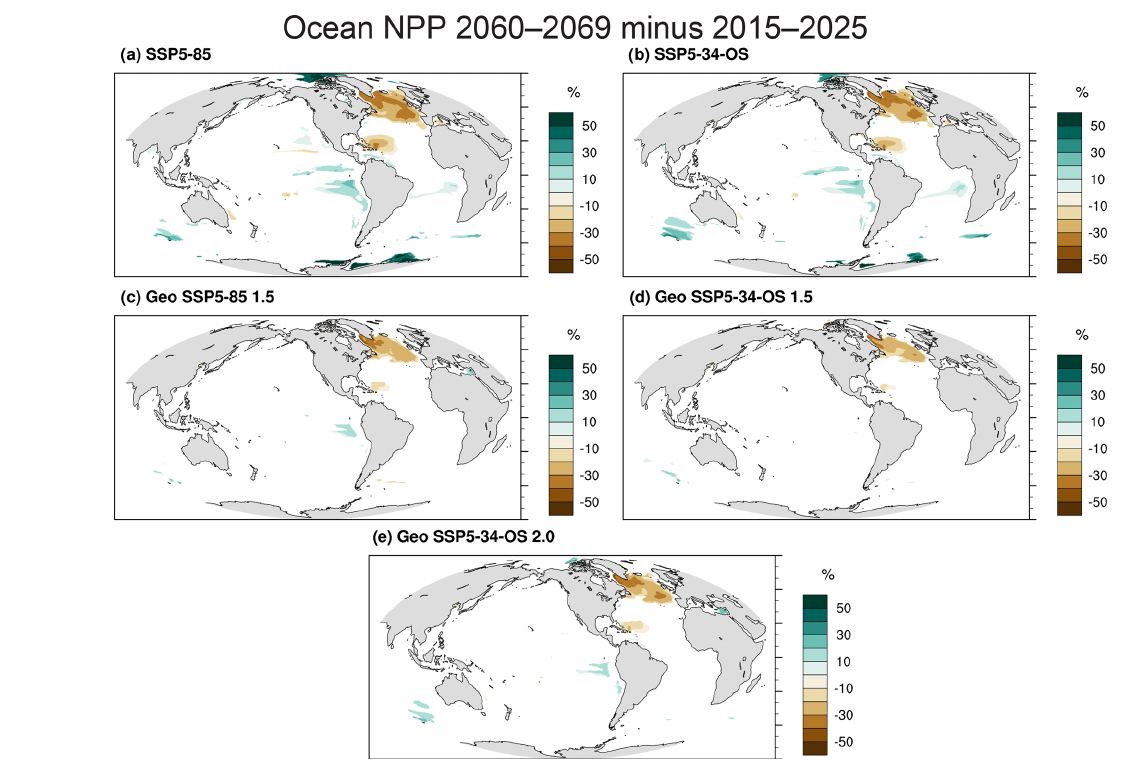
Figure 9. Ensemble mean percent difference in ocean net primary productivity (NPP) in 2060–2069 relative to 2015–2025. Regions shaded in color are significant with 95% confidence, assuming normally distributed